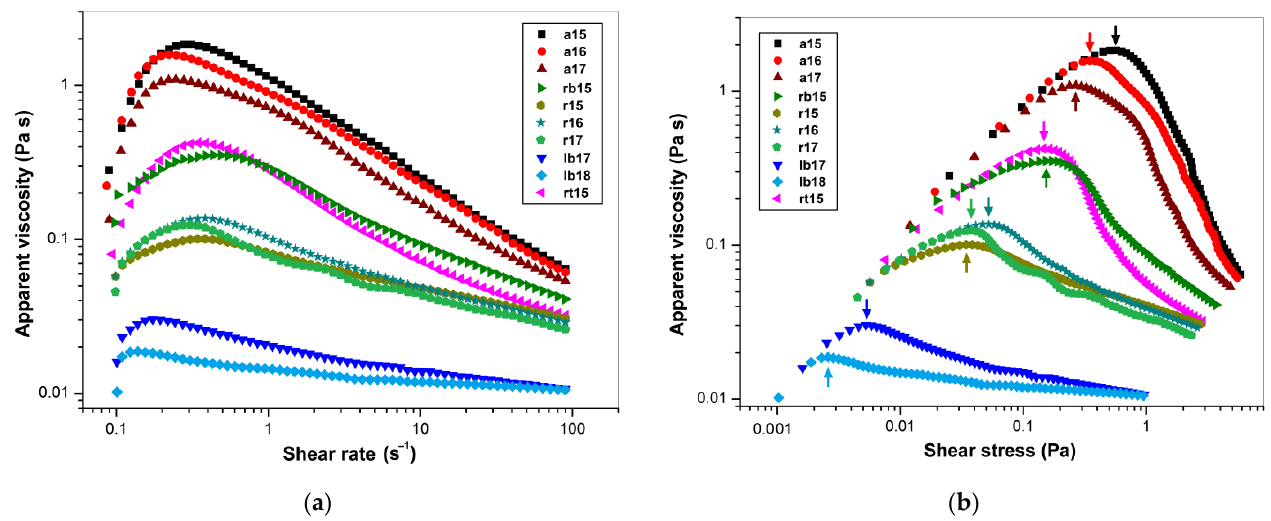
Figure 2. Steady shear flow rheograms (on a double logarithmic scale) for 1% aqueous FSM solutions: ( a ) plot of apparent viscosity versus shear rate in the forward direction; ( b ) plot of apparent viscosity versus shear stress in the forward direction. Arrows show yield points.